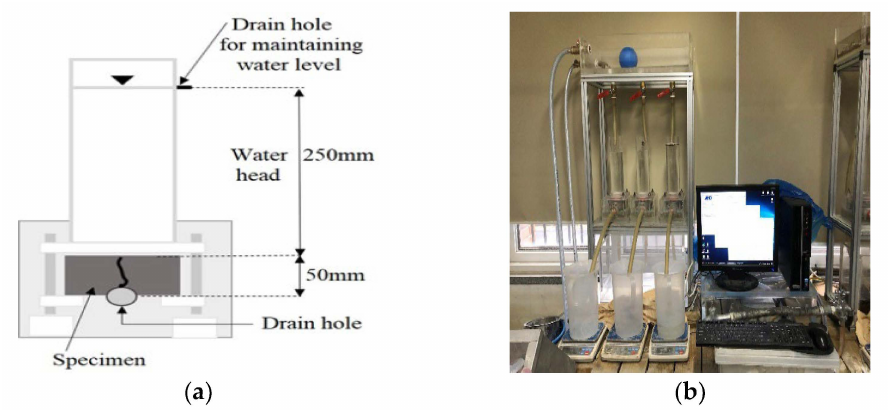
Figure 6. Water permeability test apparatus: ( a ) schematic diagram and ( b ) test setup.